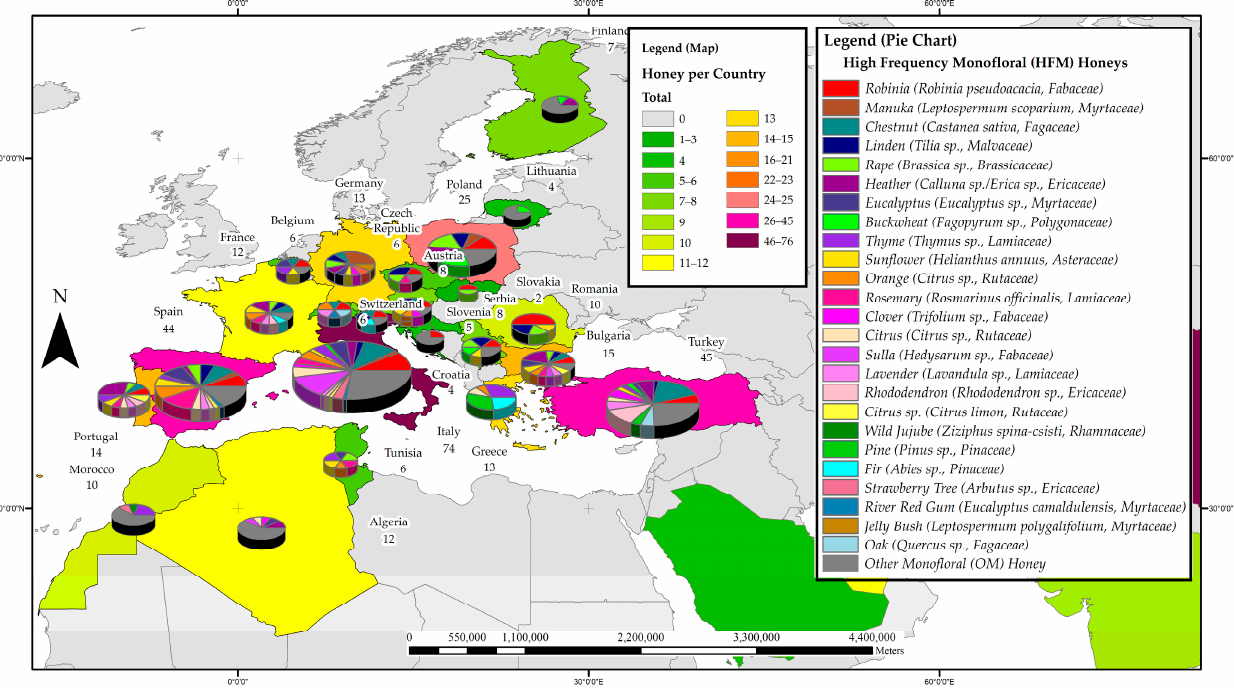
Figure 4. Most frequently studied honeys with respect to their phenolic profile in the Americas.